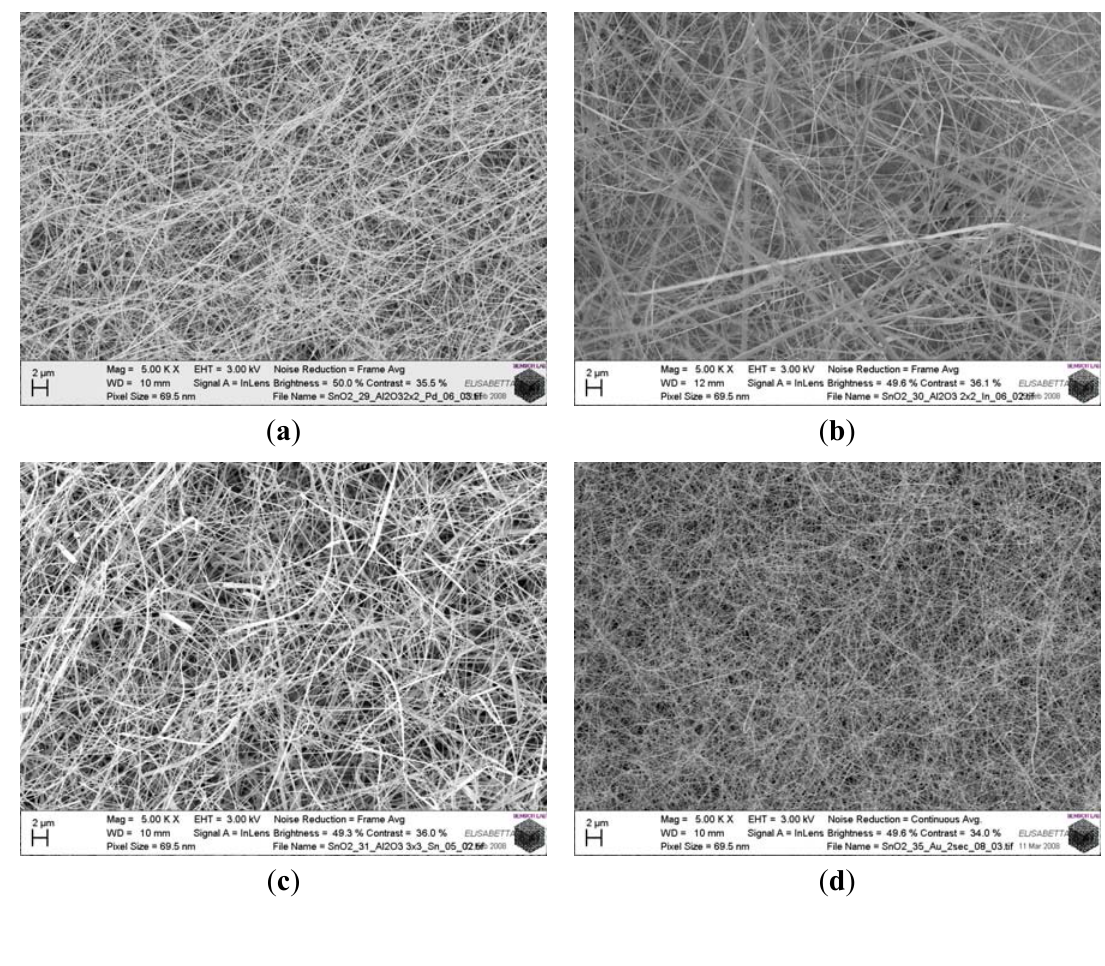
Figure 6. Different morphologies of tin oxide nanowires deposited with ( a ) palladium, ( b ) indium, ( c ) tin and ( d ) gold catalyst at 400 °C